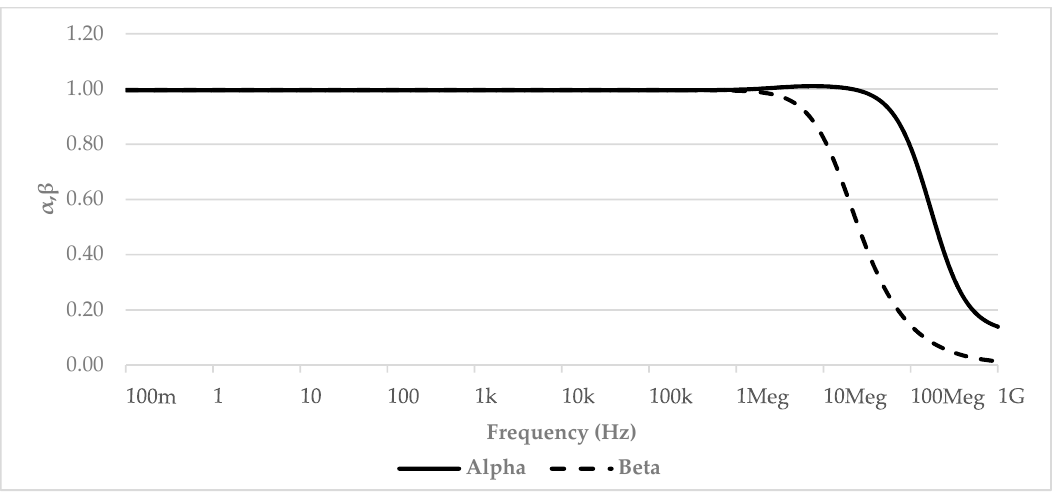
Figure 4. VCII α and β vs. frequency behavior.